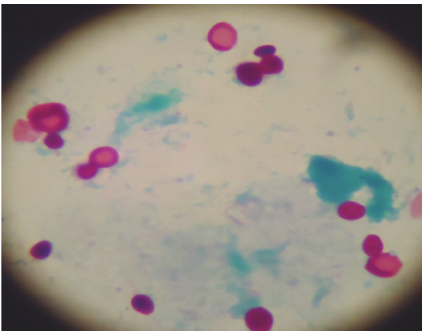
Figure 11: Yeast-like cells of Candida albicans in a smear from fungal keratitis sample stained with PAS × 1000.